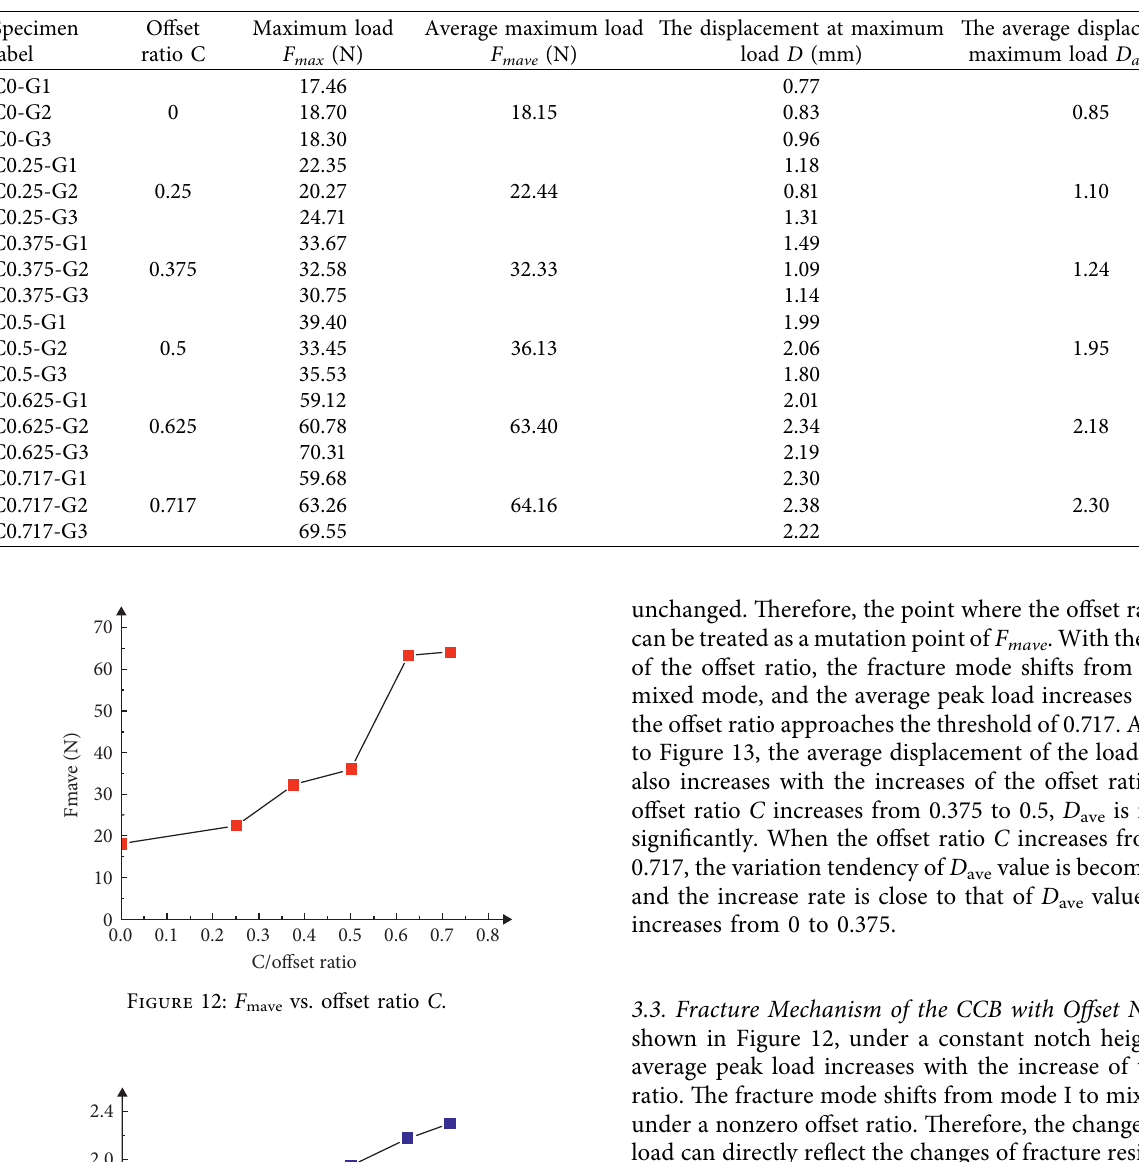
Table 1: The tested results of mechanical properties.